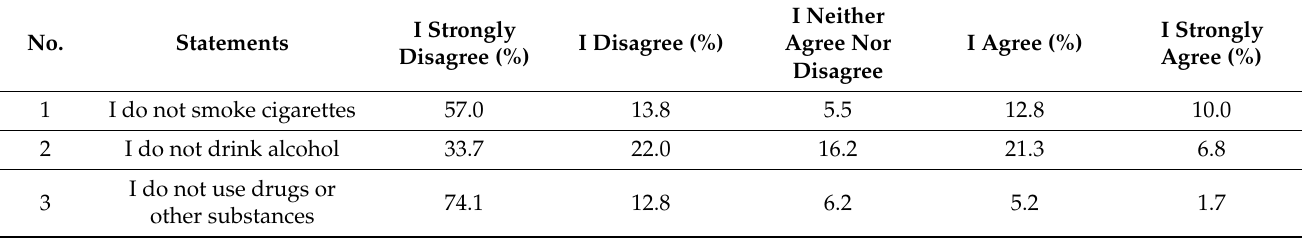
Table 3. Avoiding risky behaviours: not smoking, limited use of alcohol, not abusing medicines not prescribed by a doctor, not using other psychoactive